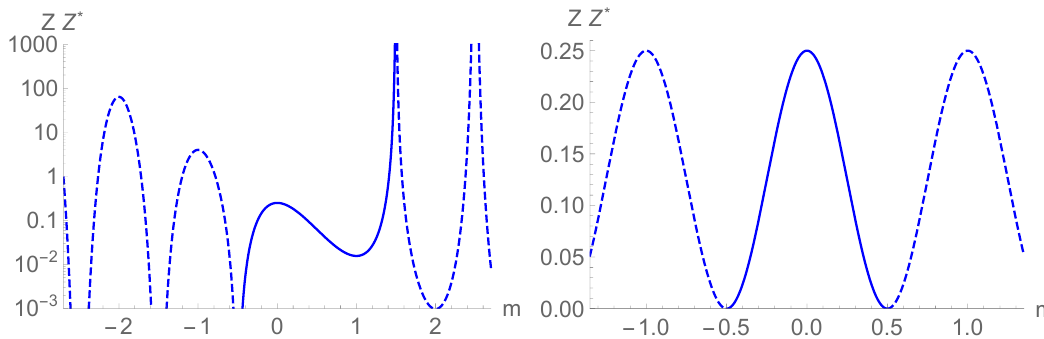
Figure 1 . The response of ZZ (cid:3) to various mass deformations for two chiral multiplets with reversed spin-statistics. We conjecture this corresponds to the Hartle-Hawking wave function in a homogeneous isotropic minisuperspace model in HS gravity. Left: both multiplets are in the same representation of the gauge multiplets inducing the mass deformation eq. (3.5) with parameter m . Right: the two multiplets are in opposite representations; one has mass parameter m and the other (cid:0) m under eq.